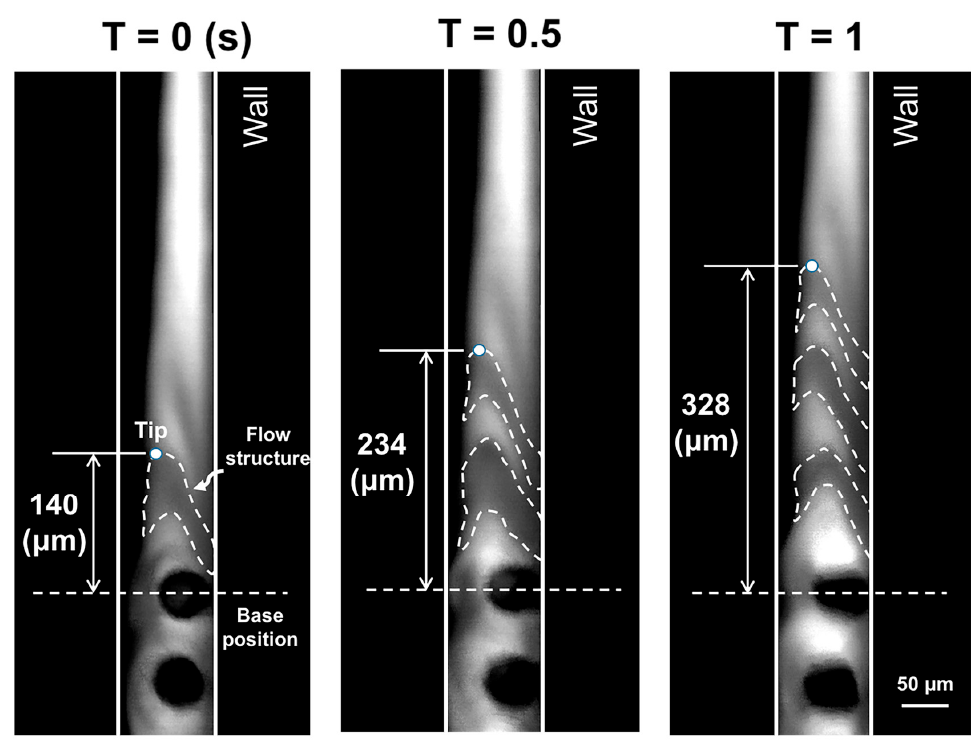
Figure 4. Time lase imaging of the flow profile illustrates the migration of the flow structure at the plane of cilia tip. plane of cilia